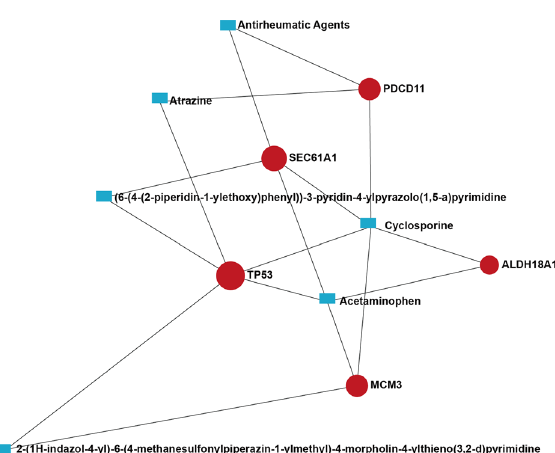
Figure 7. Protein-chemical interactions. Red spots represent hub genes; blue rectangles represent